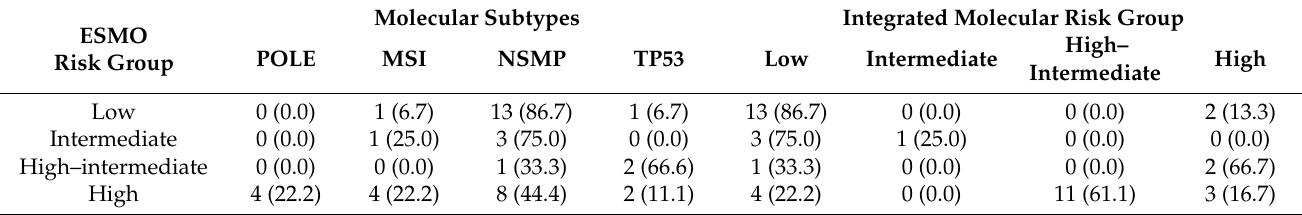
Table 3. Comparison of ESMO risk groups with molecular subtypes and integrated molecular risk groups.